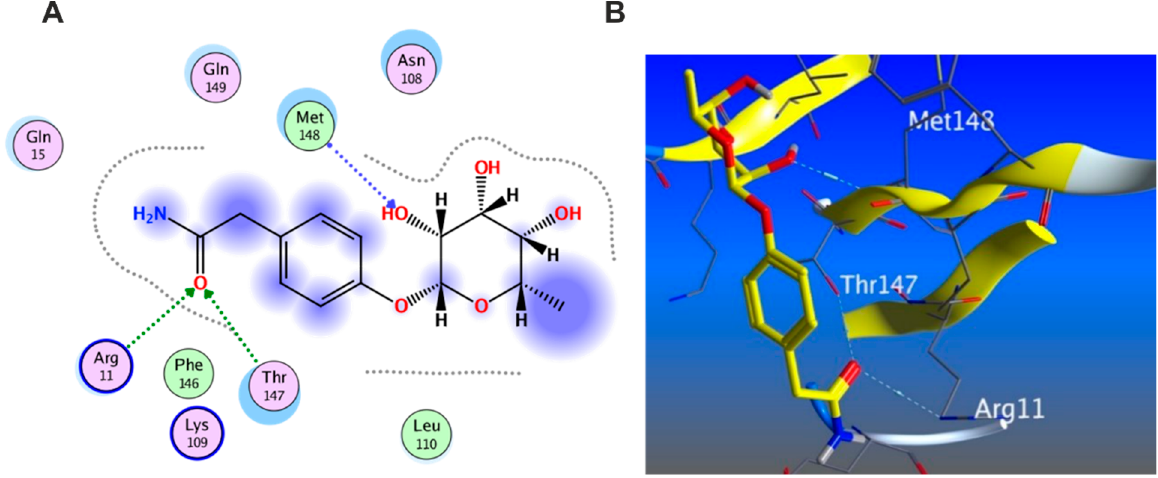
Figure 18. Docking results of compound 18 in the active pocket site of IL-1 β (PDB:6Y8M): ( A ) 2D interactions of compound 18 ( B ) 3D Docking pose of compound 18 .